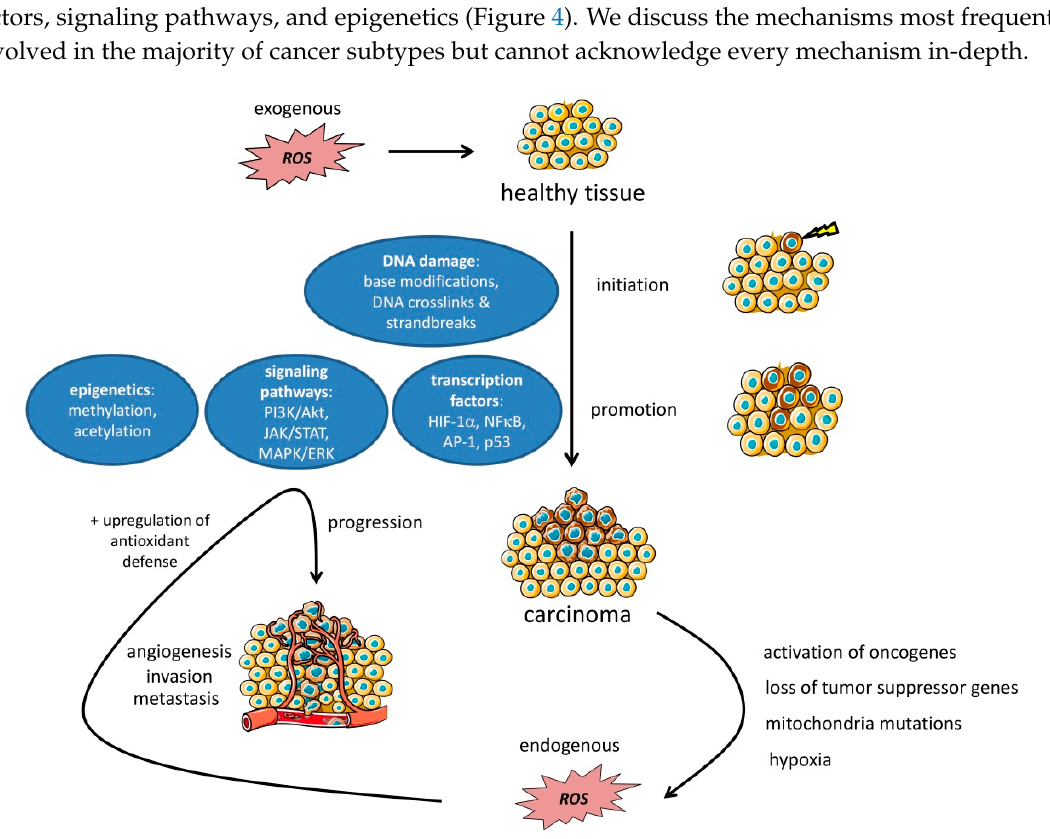
Figure 4. ROS in the TME: Non cancer-related ROS can be deleterious for healthy tissue and thereby lead to tumor initiation and promotion via DNA damage and the impairment of signaling pathways, transcription factor expression, and epigenetic changes. After the tumor initiation upregulation of oncogenes, the loss of tumor suppressor genes, mitochondria mutations, and hypoxic conditions can lead to further elevated tumor-related ROS levels. In a positive feedback loop system, rising ROS levels in the TME can in turn support tumor progression, angiogenesis, invasion, and metastasis via an amplification of the pathways involved in initiation and promotion. Finally, to protect against threshold-crossing toxic ROS levels, tumor cells initiate the upregulation of antioxidant defense mechanisms in order to prevent from ROS-related deleterious events like apoptosis or necroptosis.